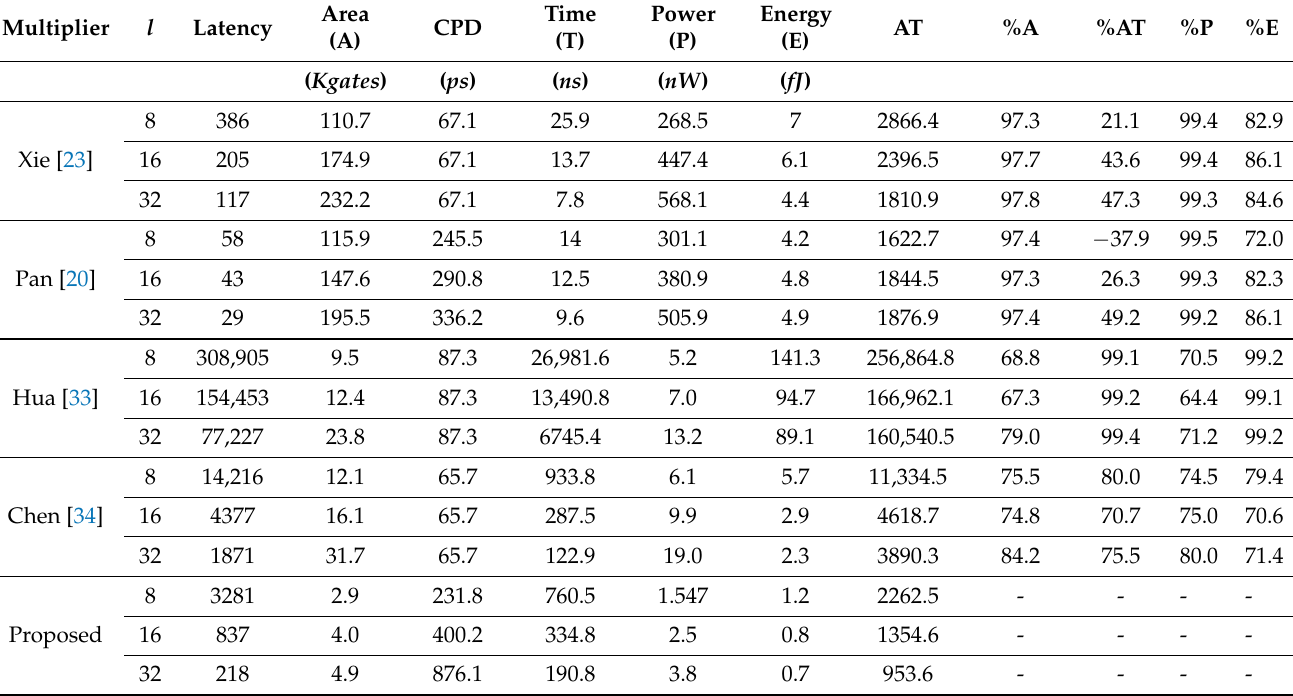
Table 3. Performance results of word-based modular multipliers for n = 508 and various embedded word sizes l